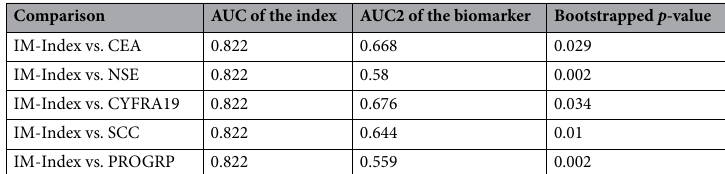
Table 2. AUC value comparison between IM-Index and 5 other lung cancer-specific biomarkers.